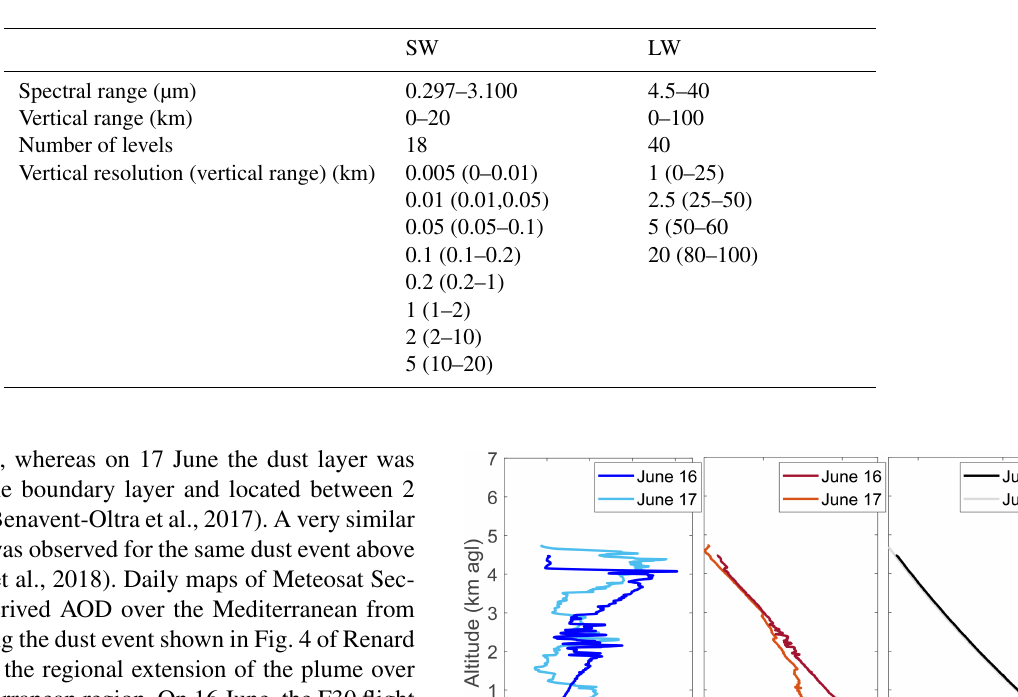
Table 1. Summary of main GAME properties for the SW and LW spectral ranges. The altitude range corresponding to the different vertical resolution values is indicated between parentheses.